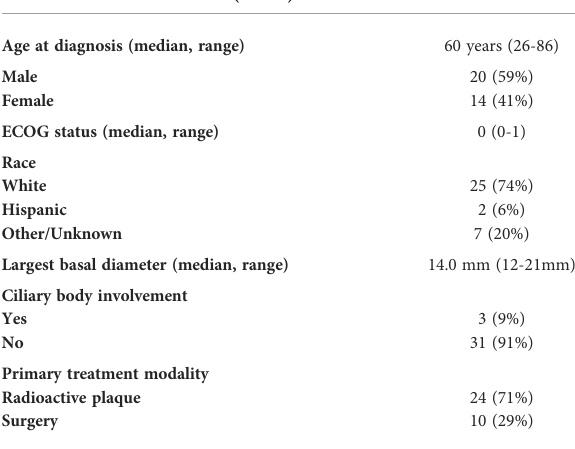
TABLE 1 Baseline